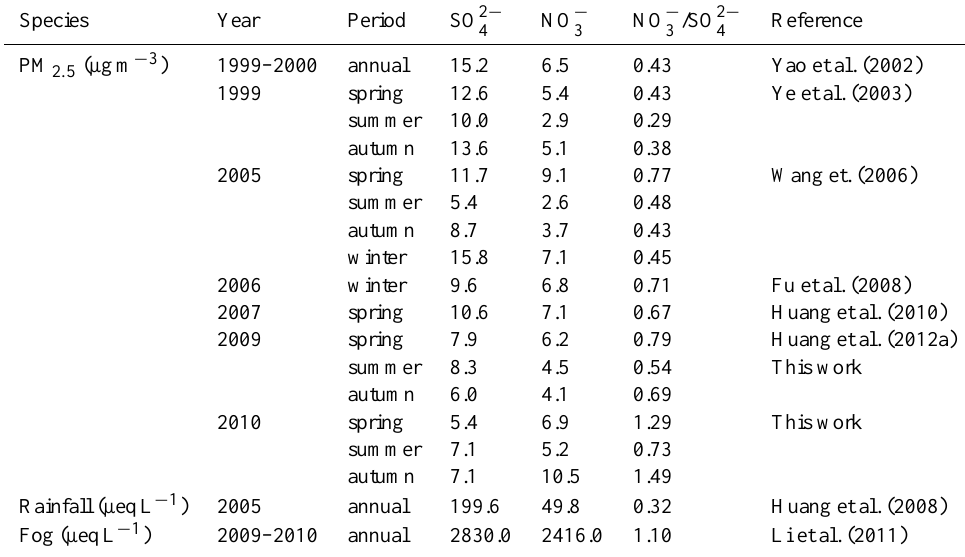
with the ratio of NO − 3